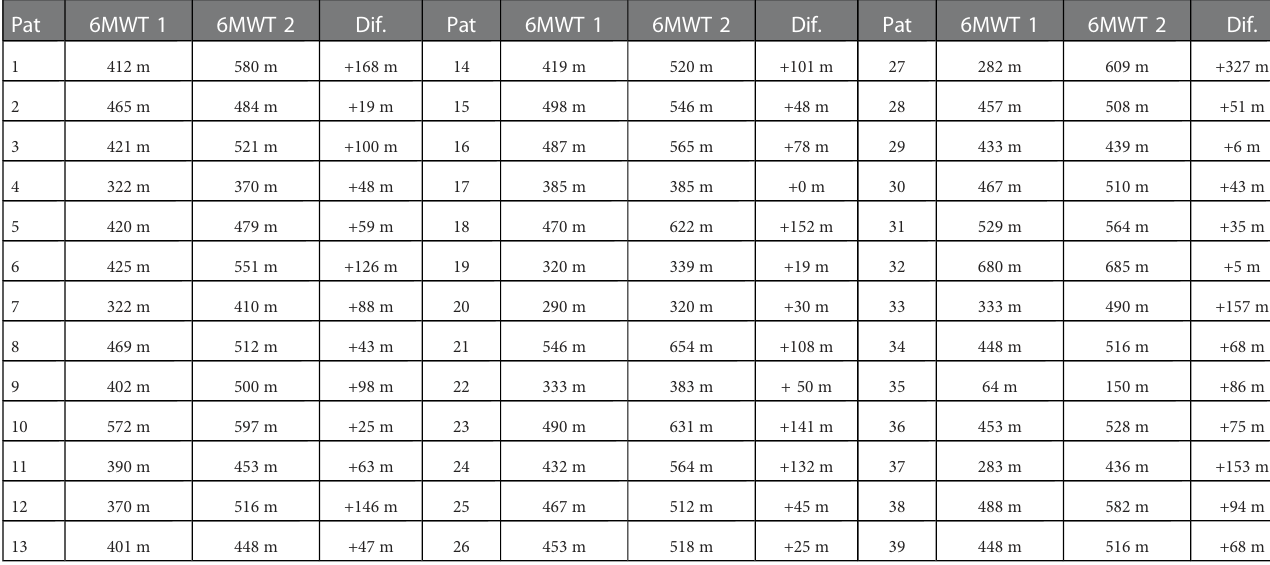
TABLE 4 Individual results of the post-COVID patients in the 6MWT.